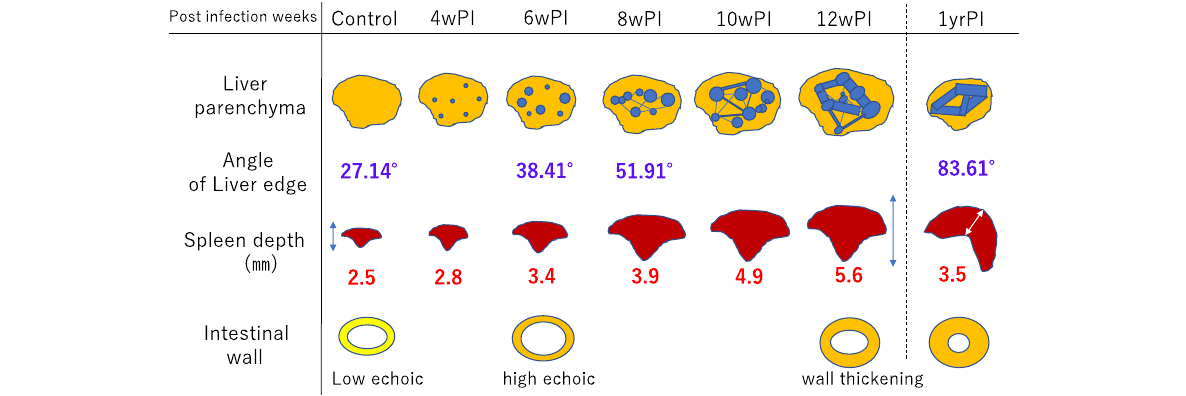
Fig. 9 Schema of hepatosplenomegaly and intestinal lesions. Along with changes in the liver parenchyma and changes in the spleen cross- section, a high-echo signal was noted indicating intestinal wall thickening, which increased in intensity over